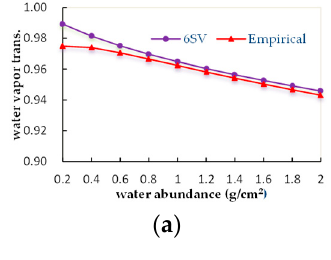
Figure 9. Comparisons of gaseous transmissions calculated using empirical formulas and by 6SV under various atmospheric conditions (water vapor transmission in infrared band ( a ); ozone trans- mission in blue band ( b ); and transmission of other gases in infrared band ( c )).